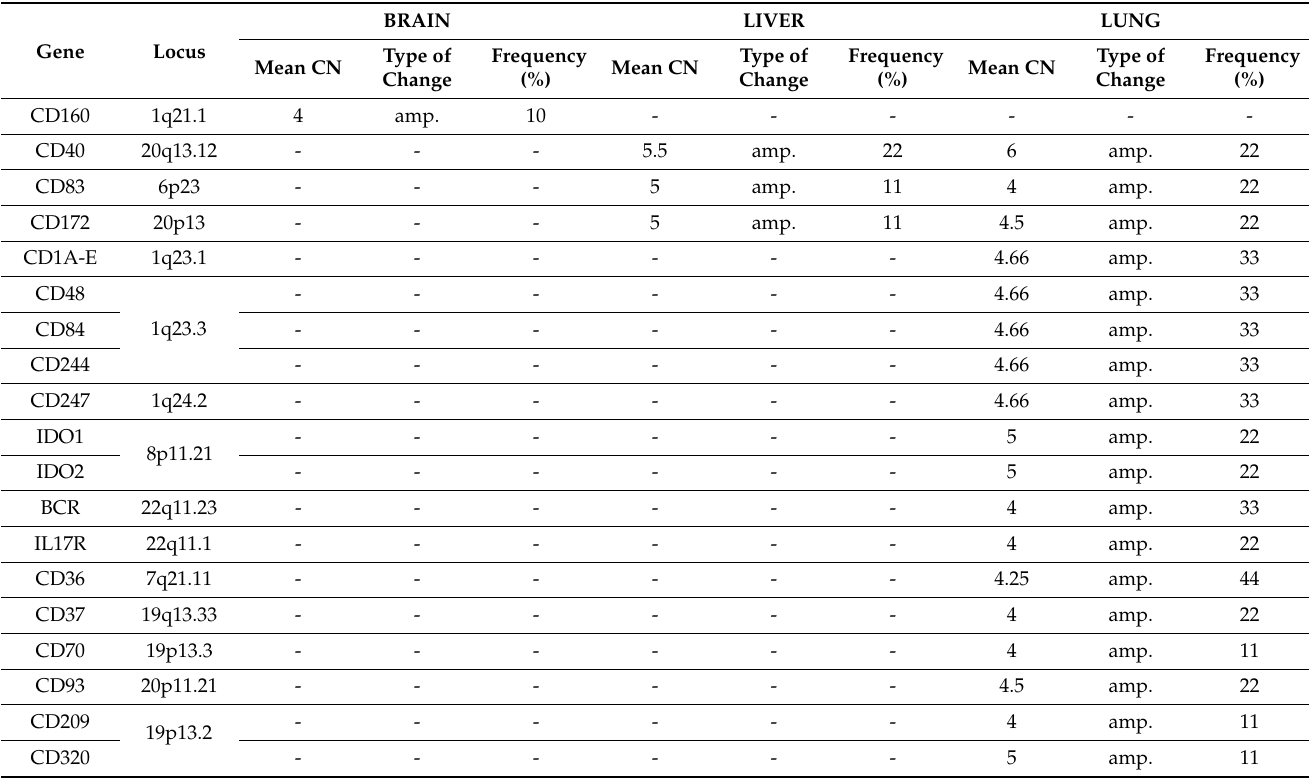
Table 3. Chromosomal regions including immune cell markers affected by amplification in melanoma metastases. BRAIN Gene Locus